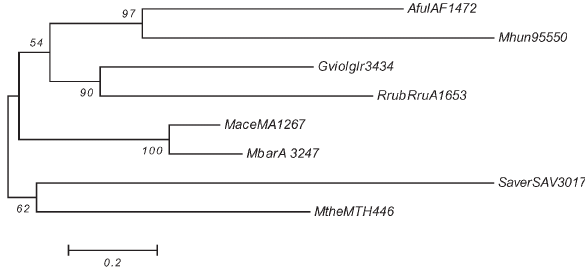
Figure 5. Phylogenetic analysis by neighbor-joining of putative two- component open reading frames (ORFs) from hybrid kinase 1 group ahy2 . The bacterial ORFs are Gviolglr3434, RrubRruA1653 and SaverSAV3017. Abbreviations: Gviolglr3434 = G. violaceus ; RrubRruA1653 = R. rubrum ; and SaverSAV3017 = S. avermitilis